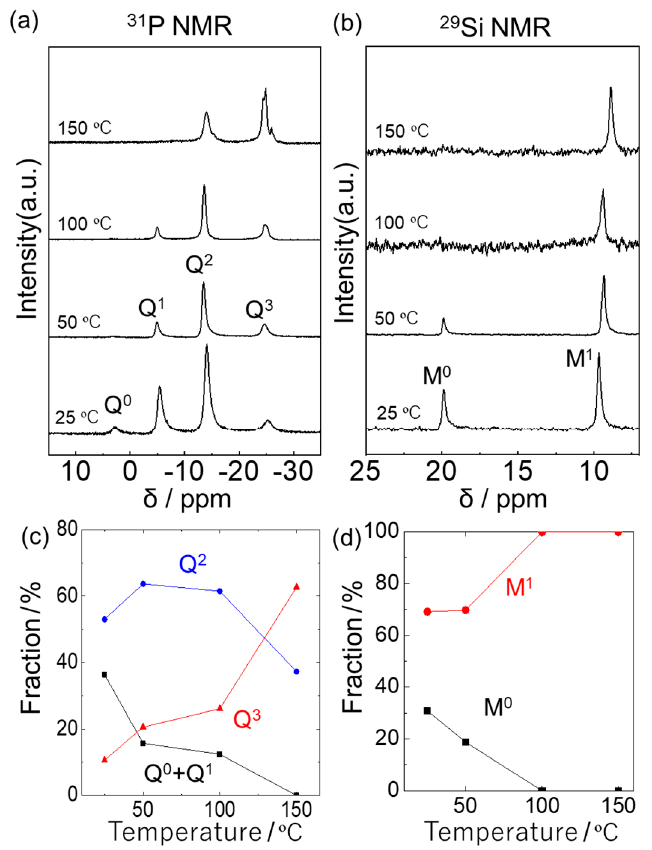
Figure 3. ( a ) The 31 P and ( b ) 29 Si NMR spectra of the products prepared from phosphoric acid and (C 6 H 4 )(Me 2 SiCl) 2 at each temperature. ( c ) The fraction of Q 0 , Q 1 , Q 2 , and Q 3 units at each temperature calculated from 31 P NMR spectra. ( d ) The fraction of M 0 and M 1 units at each temperature calculated from 29 Si NMR spectra.